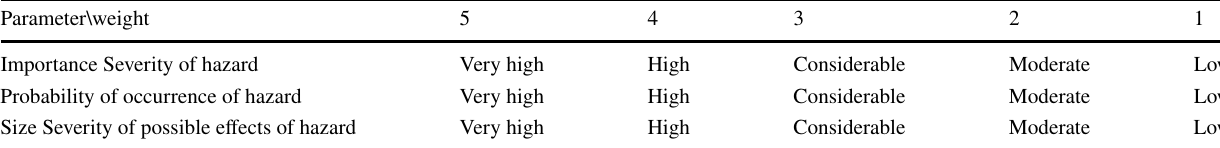
Table 1 The scale for the assessment of weights of the parameters used for the occupational risk assessment for the workplaces and for the tech- nological process